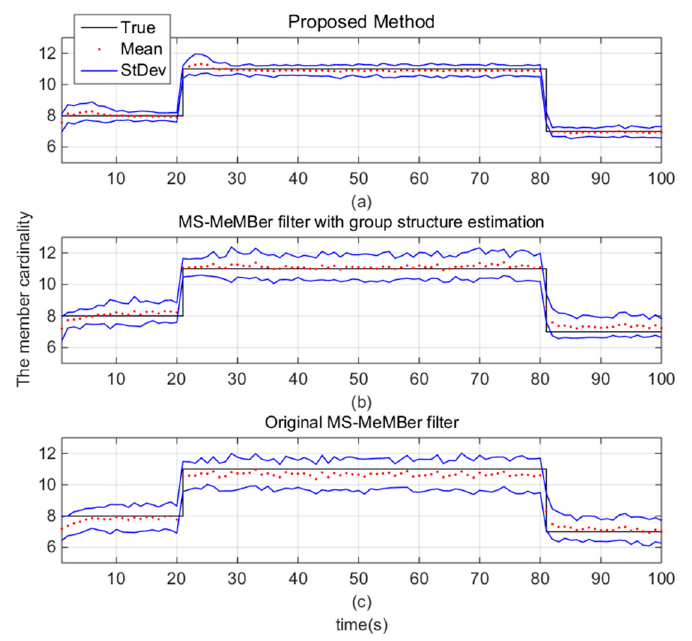
p 0.85 = . p 0.85 = . j D , j D ,